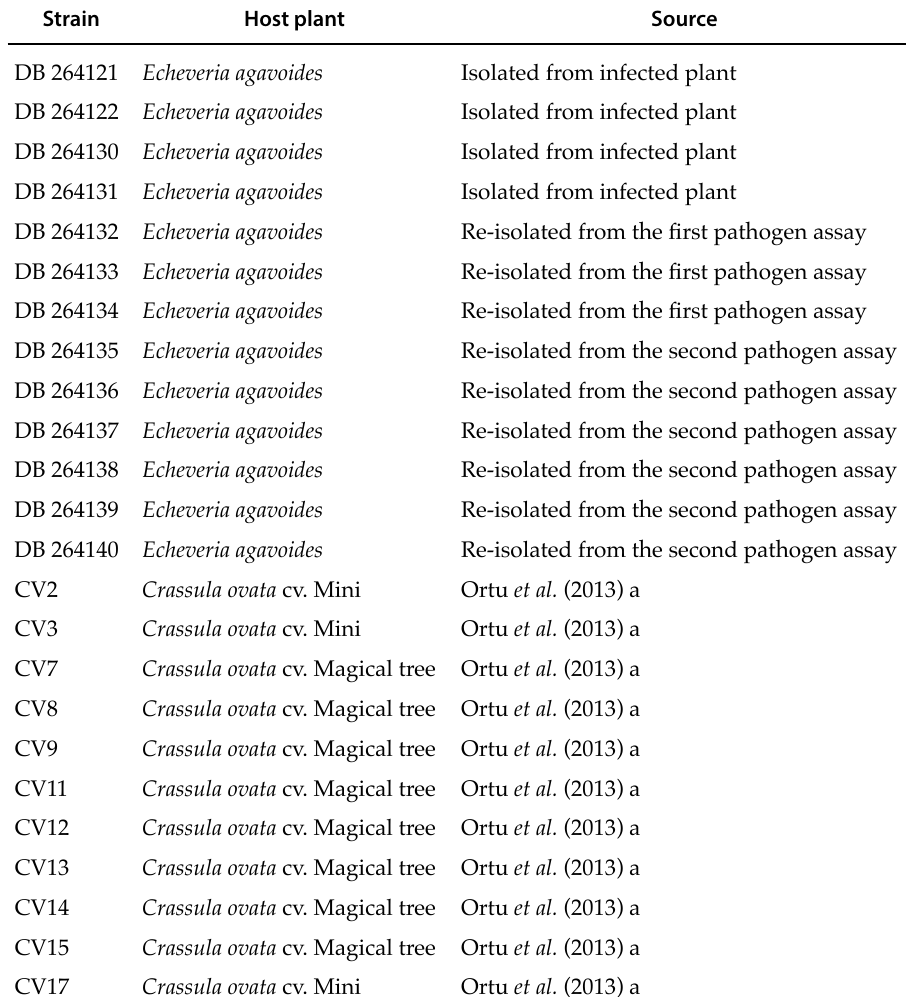
Table 1. Fusarium oxysporum isolates used in this study, all isolated in Northern